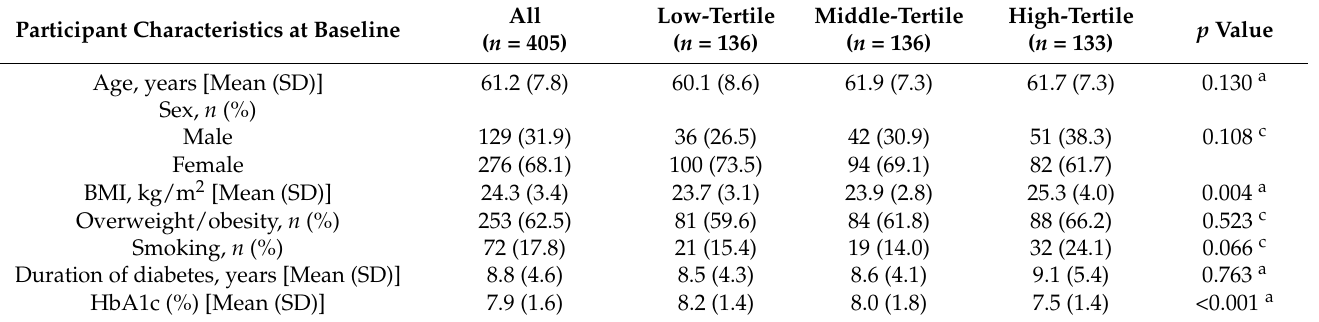
Table 1. Participant baseline characteristics for each of the serum uric acid